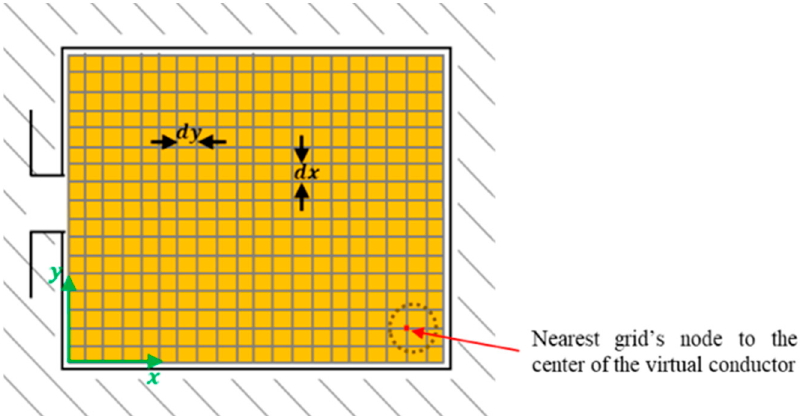
Figure 5. Nearest grid’s node to the center of the virtual conductor.